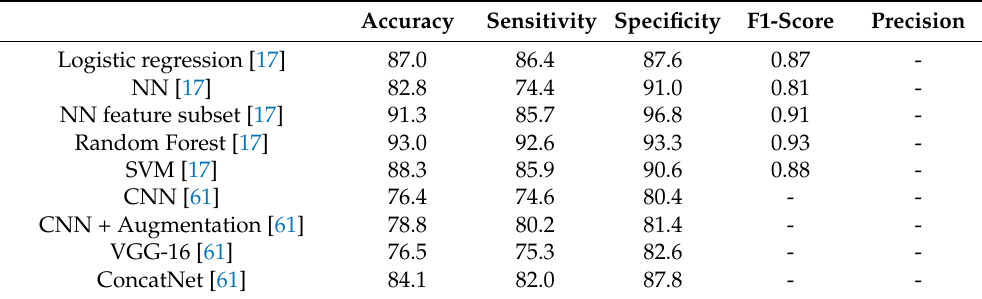
Table 6. Comparison of DenseNet-169 model with state-of-art